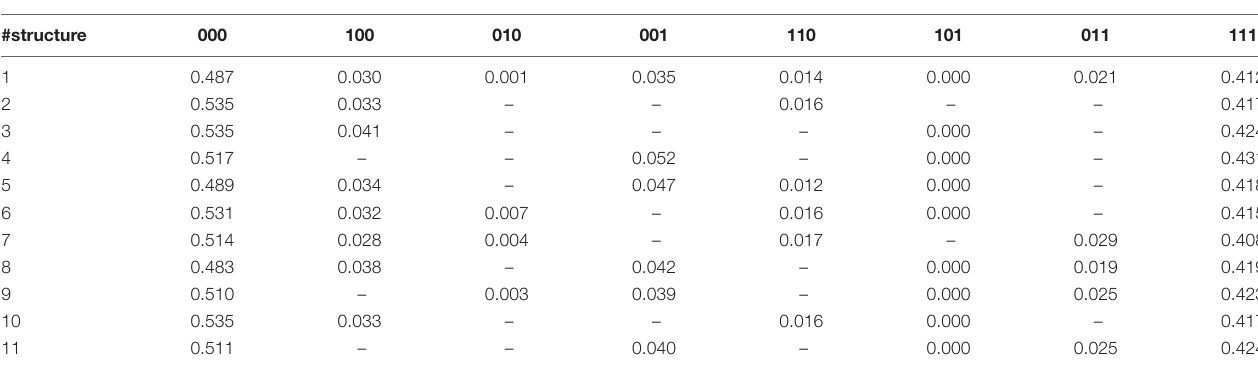
TABLE 12 | Summary of estimated proportion of each latent